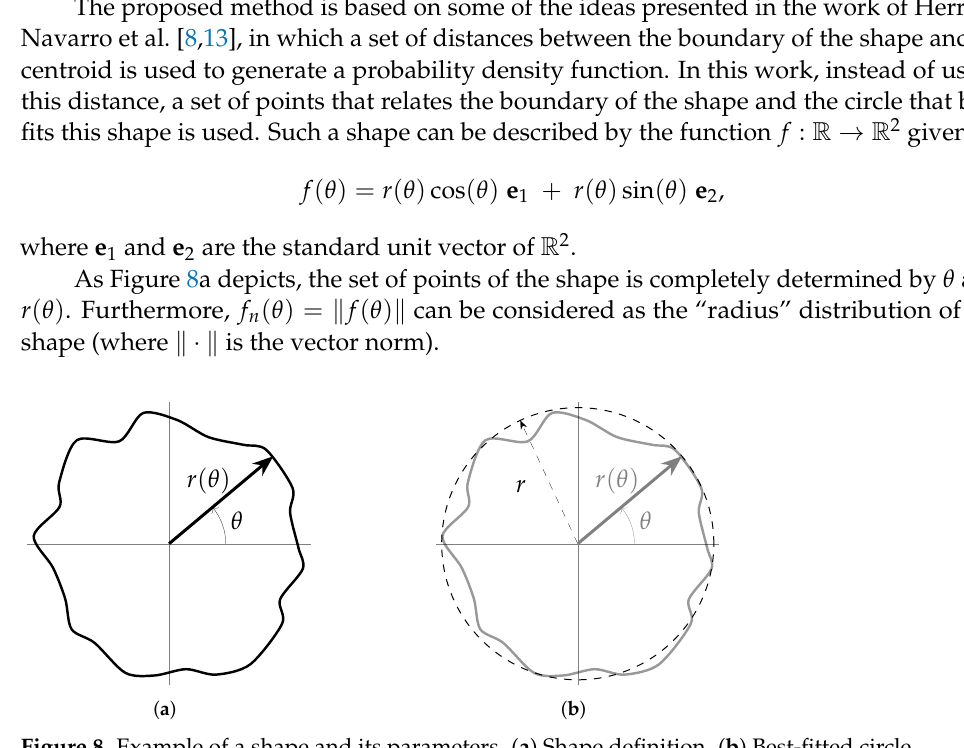
Figure 8. Example of a shape and its parameters. ( a ) Shape definition. ( b ) Best-fitted